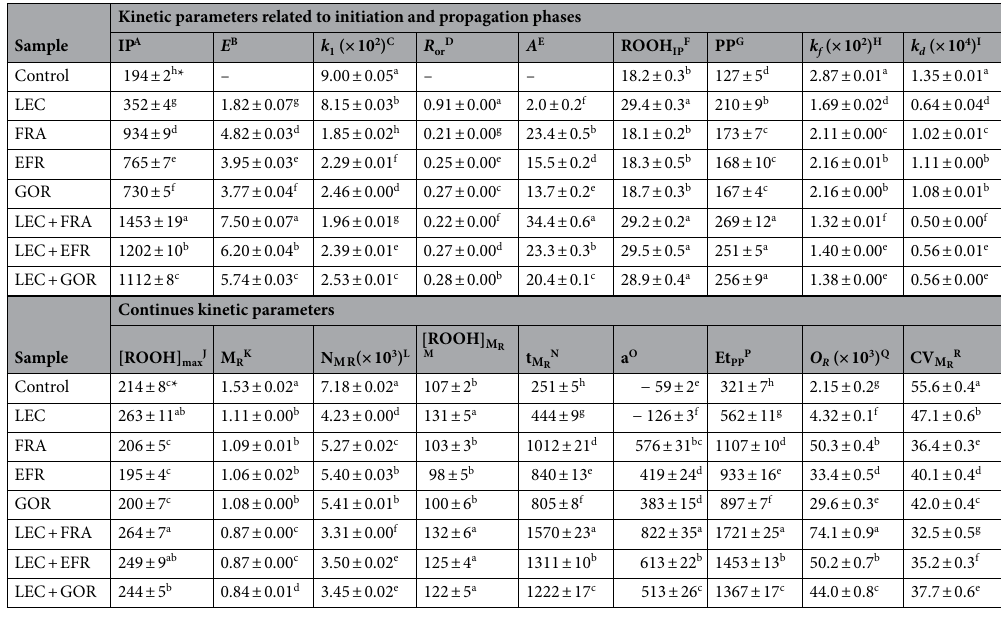
Table 1. Kinetic parameters related to the initiation, propagation, and termination phases of the stripped sunflower oil peroxidation (Control) containing lecithin (LEC), ferulic acid (FRA), ethyl ferulate (EFR), γ-oryzanol (GOR), and their combinations at 60 °C. *In each column and in each section, means (± standard deviation) with different lowercase letters are significantly different ( P < 0.05). A Induction period (min), B effectiveness, C initiation rate constant (meq kg −1 min −1 ), D ratio of the oxidation rate, E antioxidant activity, F the hydroperoxides concentration at the induction period (meq kg −1 ), G propagation period (min), H rate constant of the hydroperoxide formation in the propagation phase (min −1 ), I rate constant of the hydroperoxide decomposition in the propagation phase (meq kg −1 min −1 ), J maximum of the hydroperoxides concentration (meq kg −1 ), K maximum rate of the hydroperoxide formation (meq kg −1 min −1 ), L normalized form of the maximum rate (min −1 ), M the hydroperoxides concentration at the turning point (meq kg −1 ); N the occurrence time of the turning point (min), O overall integration constant (kg meq −1 ), P end time of the propagation phase (min), Q the oxidation resistance (min/meq kg −1 ), R carbonyl value in the turning point (μM g −1 ).